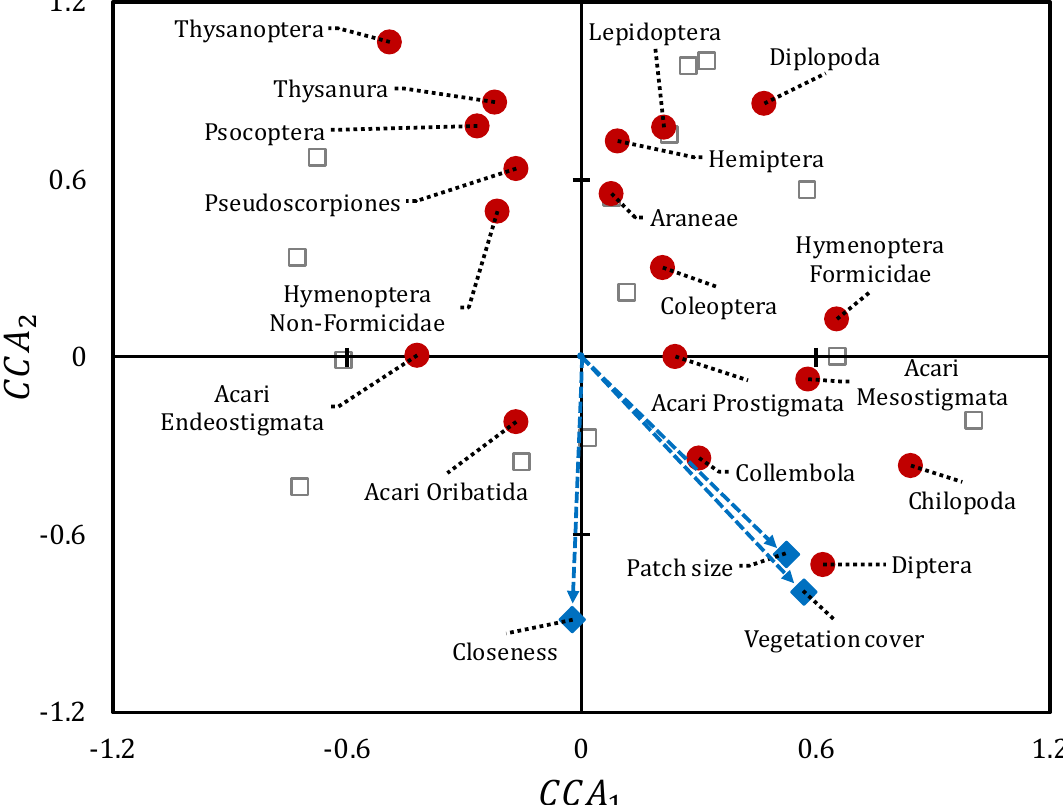
Figure 3. Variation in the composition of ground arthropod communities sampled in plots with di ff erent vegetation spatial pattern, according to the ordination resulting from Canonical Correspondence Analysis (CCA). Open gray squares: plots; filled red circles: taxa; filled blue diamonds: vegetation pattern variables; blue arrows: direction of increasing values; Vc: vegetation cover; Ps: average size of patches; Cl: closeness between patches. Acari Endeostigmata (R 2 = 0.58); Acari Oribatia (R 2 = 0.46); Acari Prostigmata (R 2 = 0.47); Acari Mesostigmata (R 2 = 0.66); Araneae (R 2 = 0.35); Chilopoda (R 2 = 0.56); Coleoptera (R 2 = 0.13); Collembola (R 2 = 0.69); Diptera (R 2 = 0.59); Diplopoda (R 2 = 0.45); Hemiptera (R 2 = 0.47); Hymenoptera Formicidae (R 2 = 0.29); Hymenoptera non-Formicidae (R 2 = 0.16); Lepidoptera (R 2 = 0.14); Psocoptera (R 2 = 0.48); Pseudoscorpiones (R 2 = 0.20); Thysanoptera (R 2 = 0.33); Thysanura (R 2 = 0.29).